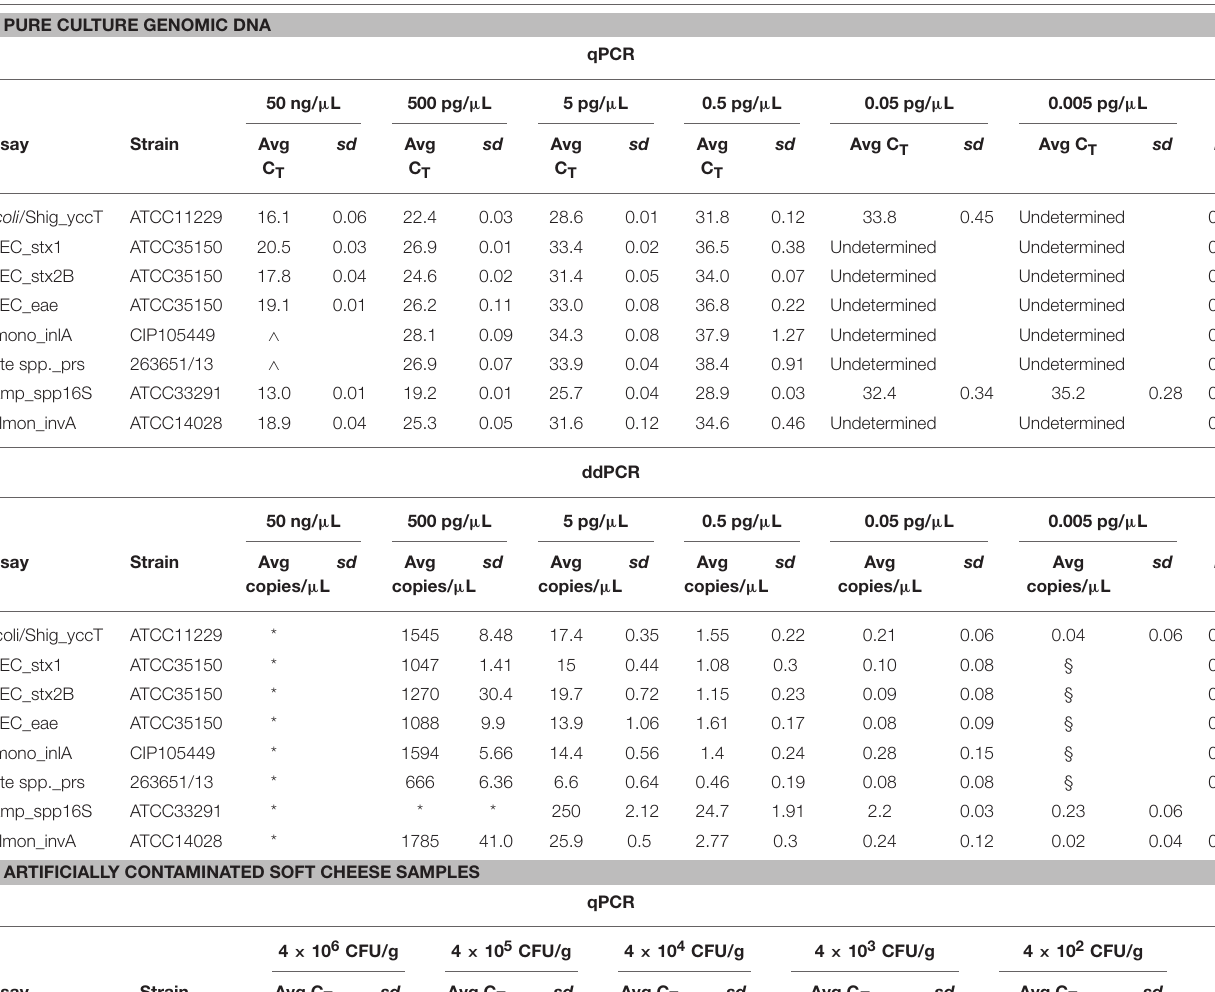
TABLE 3 | Sensitivity and efficiency of the TaqMan TM assays obtained by series of 100-fold dilutions of the pure culture genomic DNA (from 50 ng/ µ L up to 0.005 pg/ µ L; A) and with artificially contaminated soft cheese sample using tenfold dilution of 3 bacterial pure cultures (from 4 × 10 6 CFU/g up to 4 × 10 4 CFU/g; B) by qPCR and